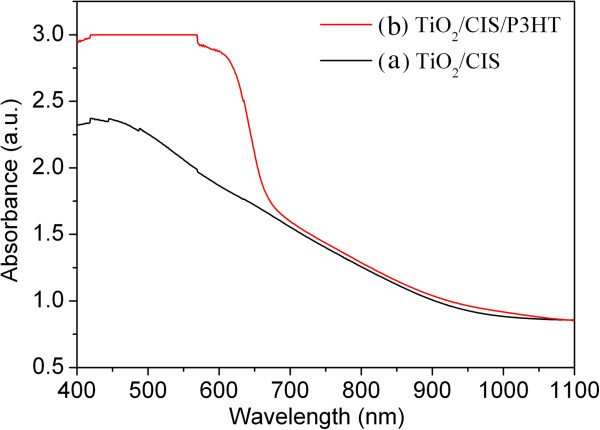
UV-vis/NIR absorption spectra. TiO2/CIS (a) and TiO2/CIS/P3HT (b) film samples.